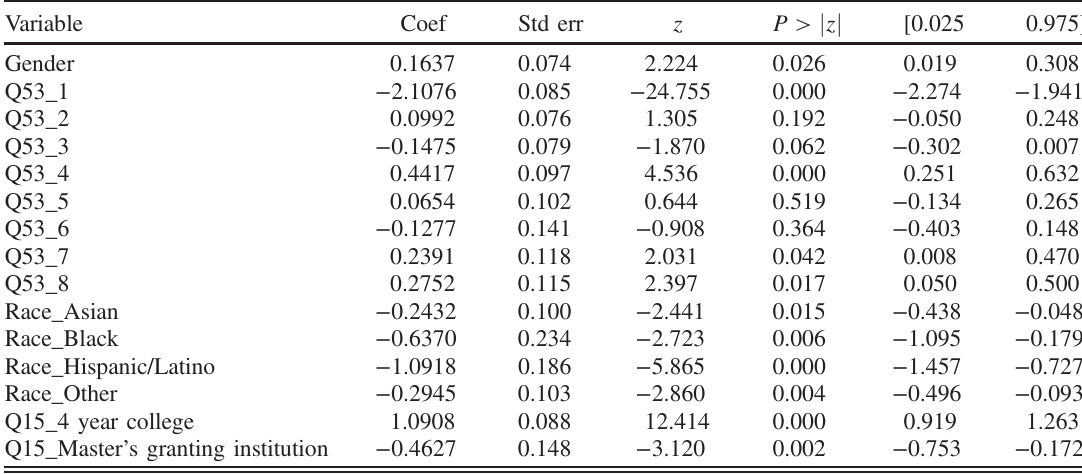
TABLE VIII. The logistic regression results for the E-CLASS